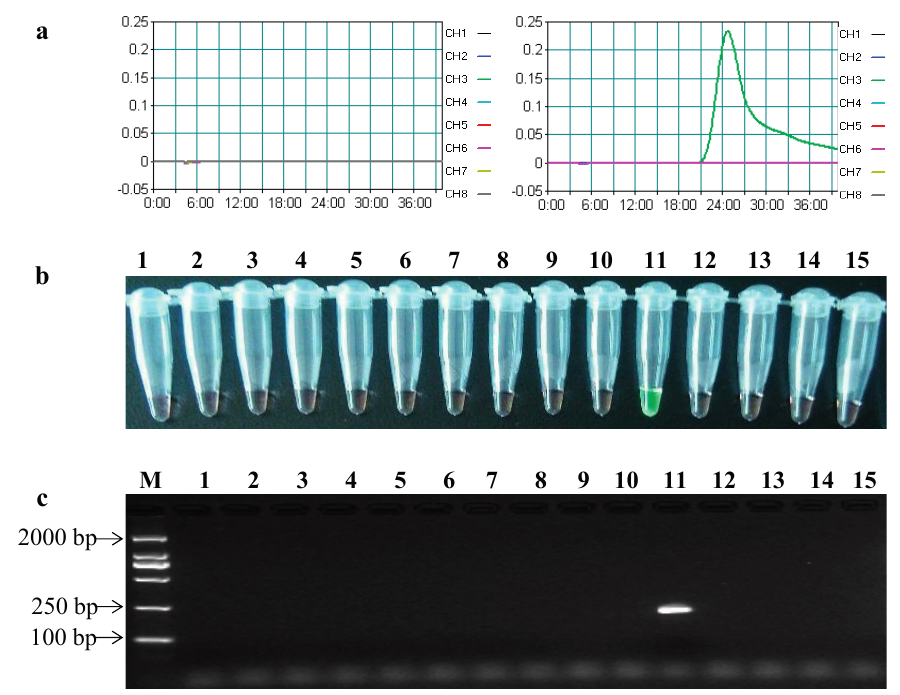
Figure 3. Specificity of the LAMP assay and conventional PCR of the cry3A gene. ( a ) The time threshold curves of the LAMP assay observed by using the LA-320C turbidimeter. ( Right ) CH1, GM maize MON89034; CH2, GM maize MON810; CH3, GM maize